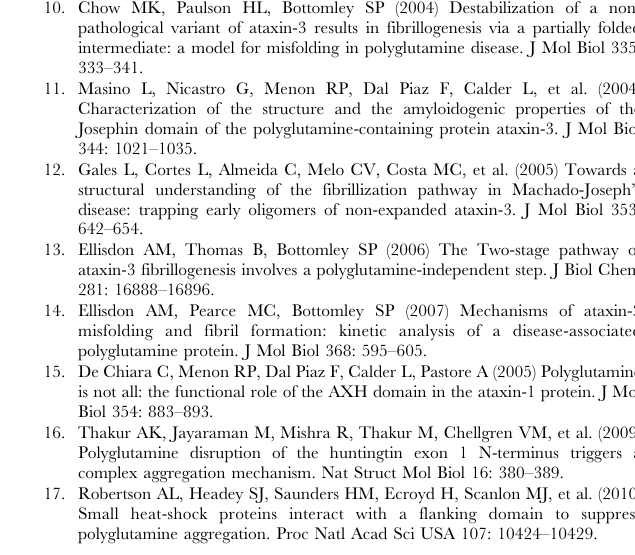
Figure S1 FTIR second derivative spectra of AT3 variant aggregates. AT3 variants were incubated at 37 u C for